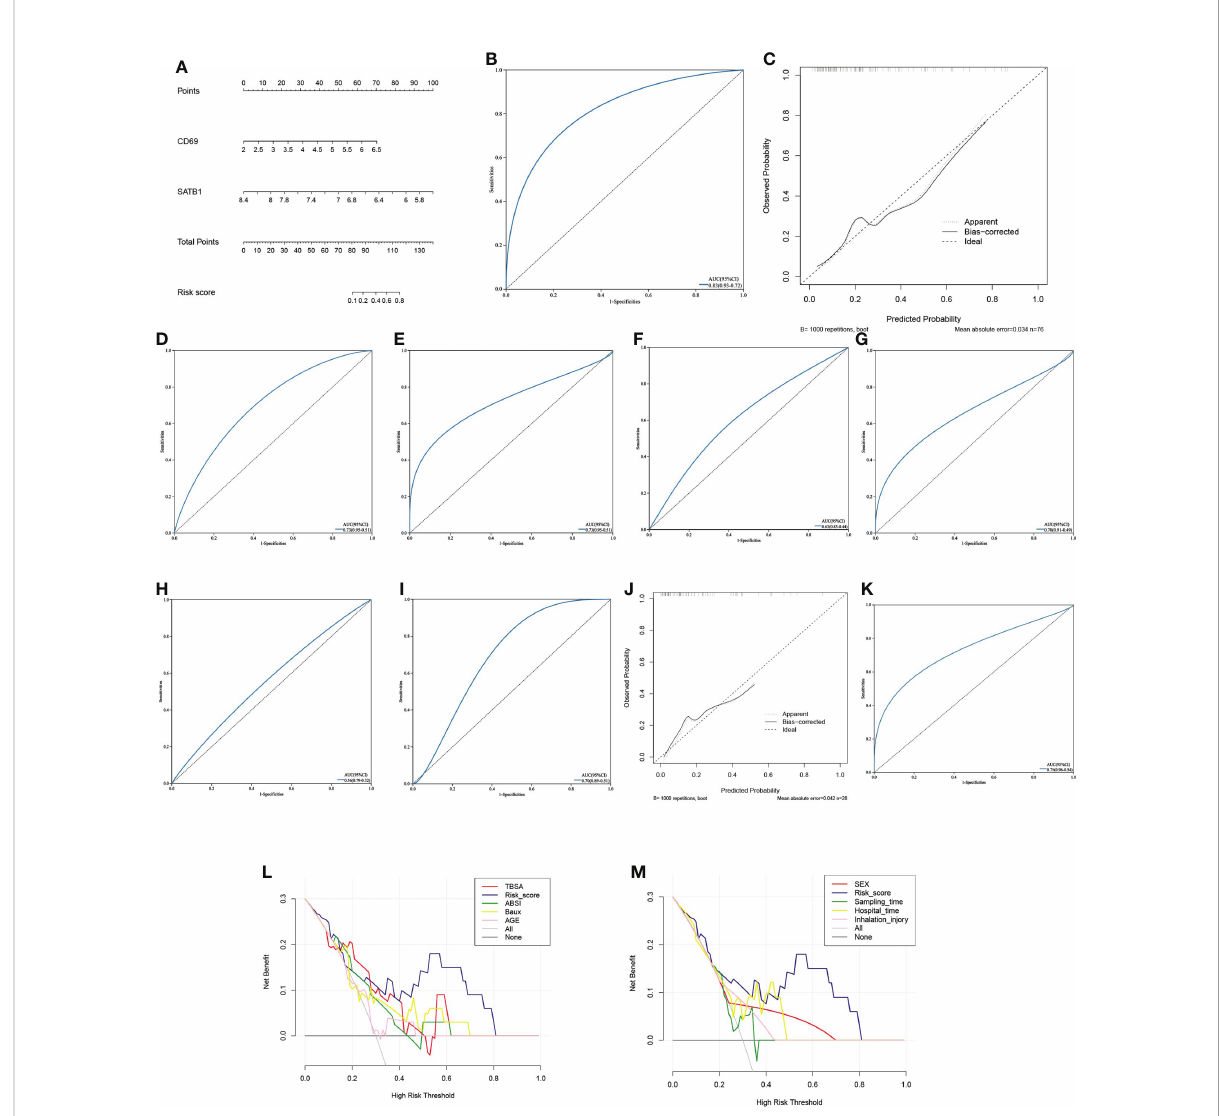
FIGURE 7 Predictive model (A) The Nomogram chart is constructed by multivariate logistic regression, which scores patients according to the gene value, and then predicts the risk of death. (B) The ROC curve of the nomogram in the training set: the larger the AUC value, the better the prediction performance. (C) The calibration curve of the nomogram in the training set: the higher the degree of coincidence with the diagonal line, the better the prediction performance. (D – I) . ROC curves of TBSA, hospital time, inhalation injury, Baux, age, and ABSI in the validation set (J) The calibration curve of the nomogram in the validation set. (K) ROC curve of the nomogram in the validation set. (L, M) . In the decision curve of the validation set ’ s nomogram, the risk cutoff value is the horizontal axis, and the larger the vertical axis, the better the prediction performance. Nomoram ’ s risk score has the best predictive